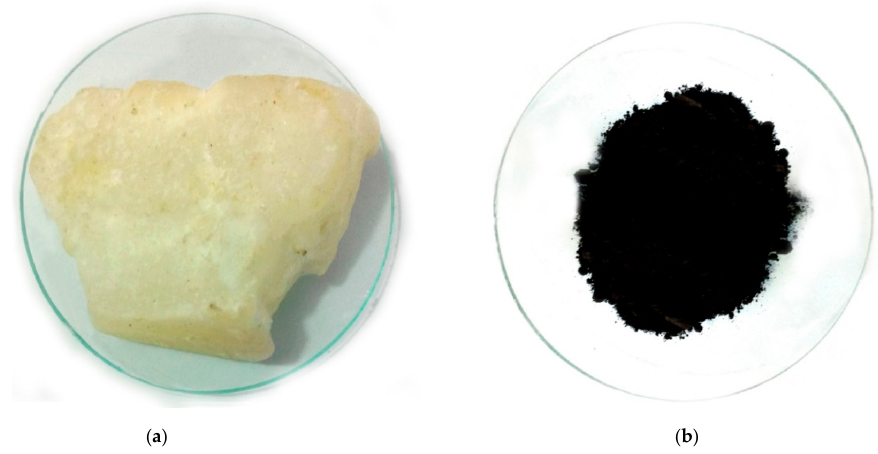
ffi n and ( b ) graphene oxide.